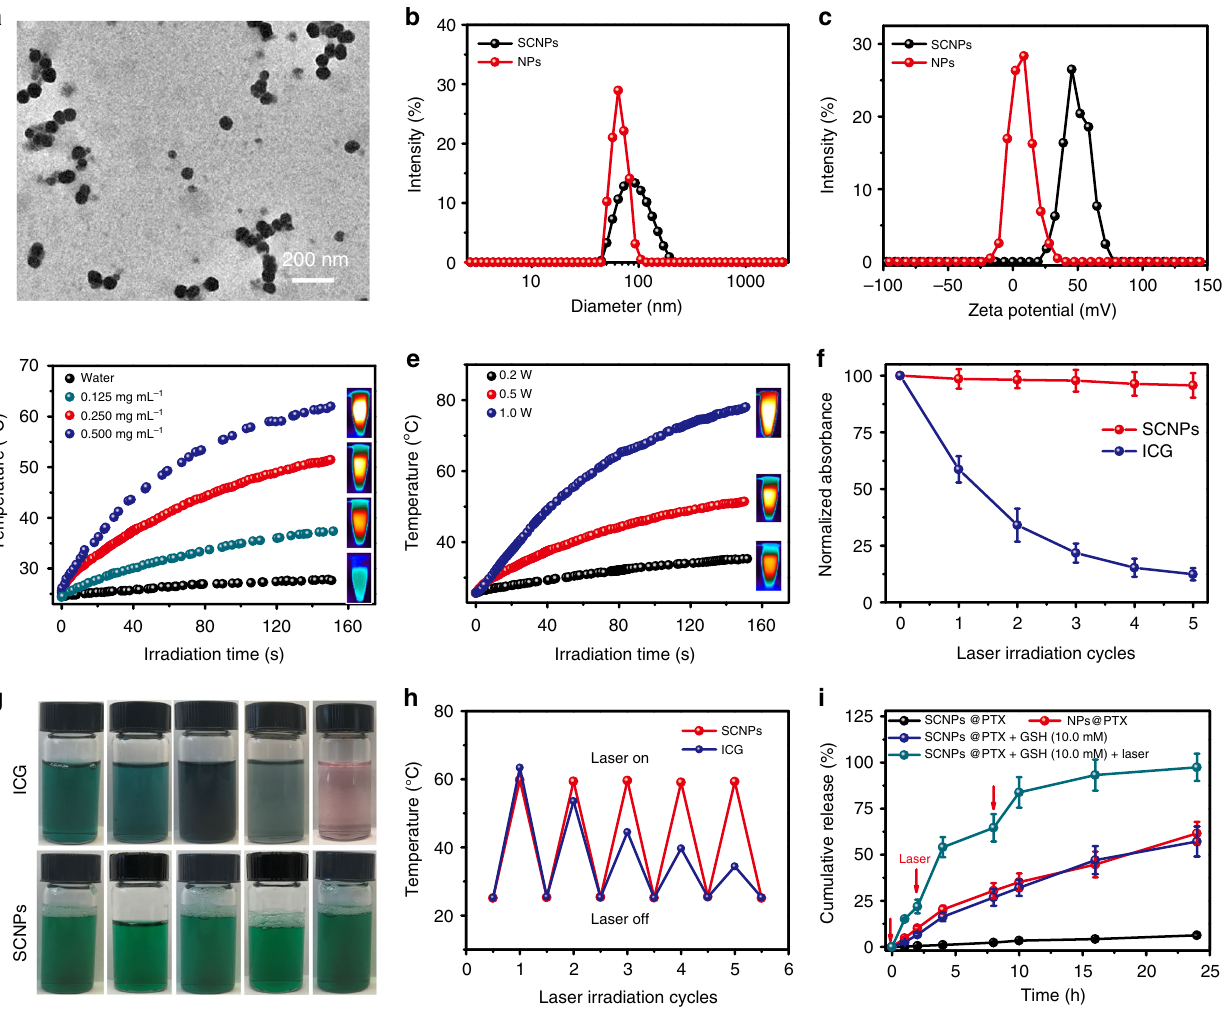
Fig. 3 Preparation of SCNPs and stimuli-responsive drug release. a TEM image of SCNPs. b DLS results and c zeta potential of the NPs formed from PDI- PCL- b -PEG-RGD ⊃ β -CD-NH 2 and SCNPs. d The photothermal curves of pure water and SCNPs at different concentrations under 671 nm laser irradiation